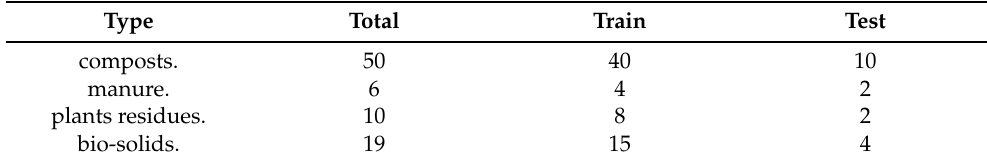
Table 1. Train test split from each sample. Type Total